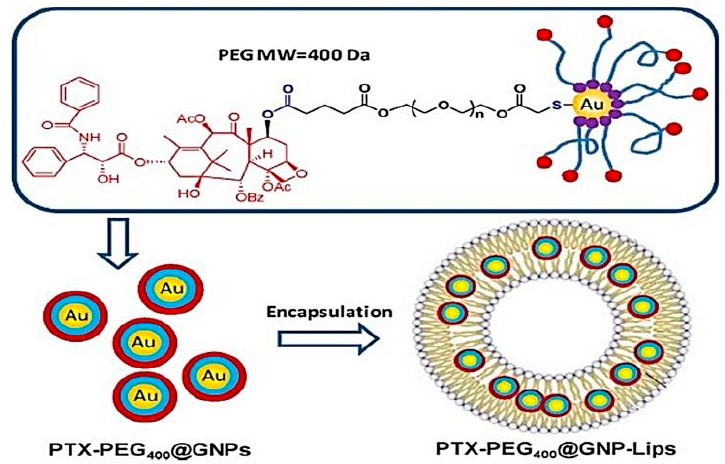
Figure 6. The chemical structure of paclitaxel-conjugated gold nanoparticles (PTX–PEG400@GNPs) and composition encapsulated liposomes (PTX–PEG400@GNP–Lips). This image was reproduced with permission from [80]. Copyright©, 2014, Elsevier.